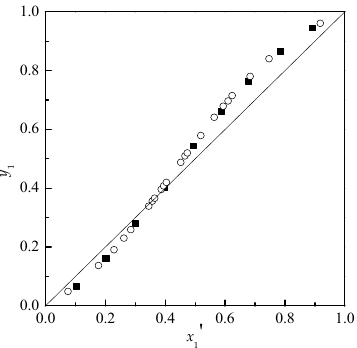
Figure 1. Isobaric vapor-liquid equilibrium (VLE) diagram for the system of acetone (1) + chloroform (2) at 101.3kPa. ■ Experimental value, ○ Literature value.